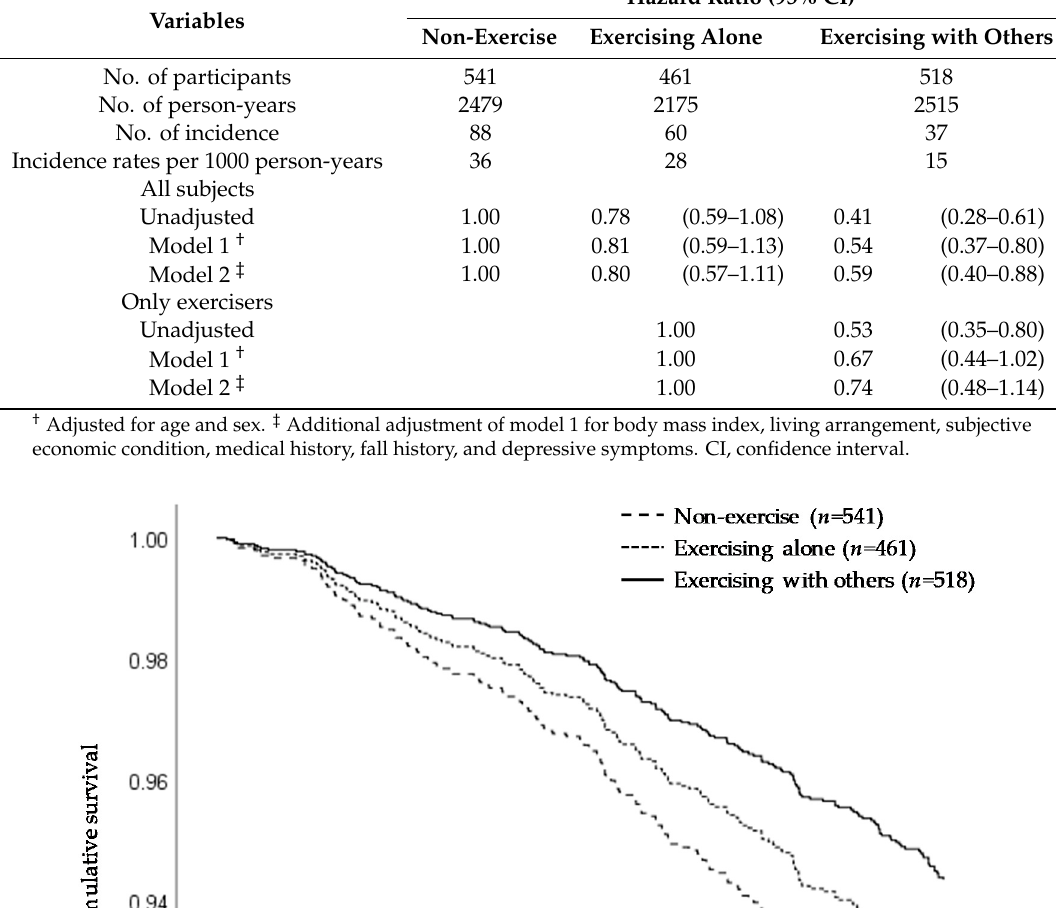
Table 2. Hazard ratios for the five-year incident functional disability according to exercise habits.